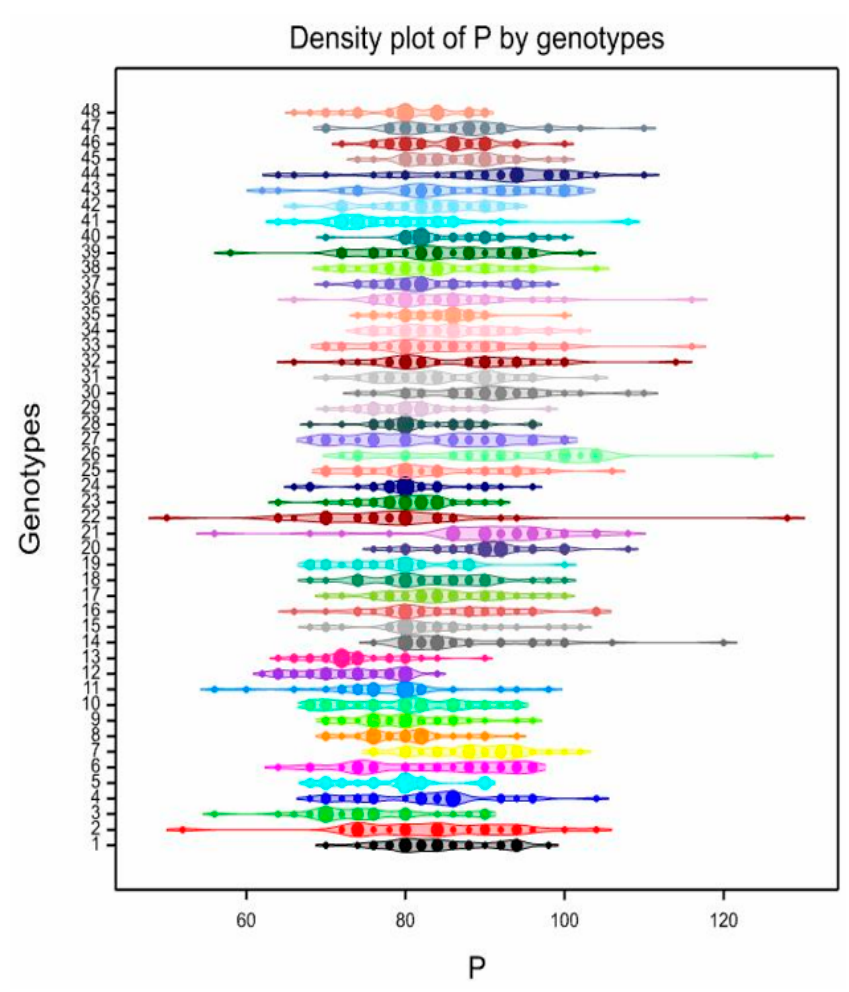
Figure 5. The density plot for the distribution of the shortest mean polar axis (P), classified by Abies alba genotypes. The observations are plotted along a line, with kernel density smoothed on either side to indicate the density of observations along the line. Numbers from 1 to 48, see Table 1.